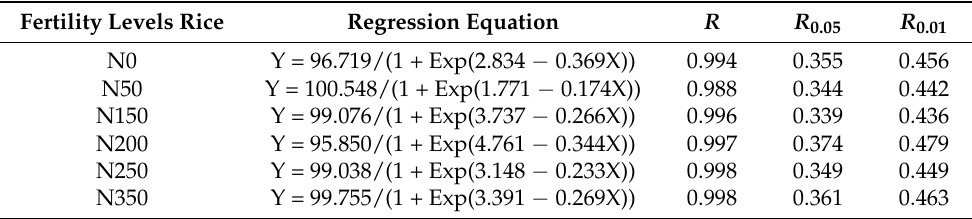
Figure 2. Adult cumulative mortality of S. furcifera on rice with different nitrogen fertilizer applications. Table 2. Curve equation from a regression between adult cumulative mortality and feeding days on rice with different nitrogen fertilizer applications.